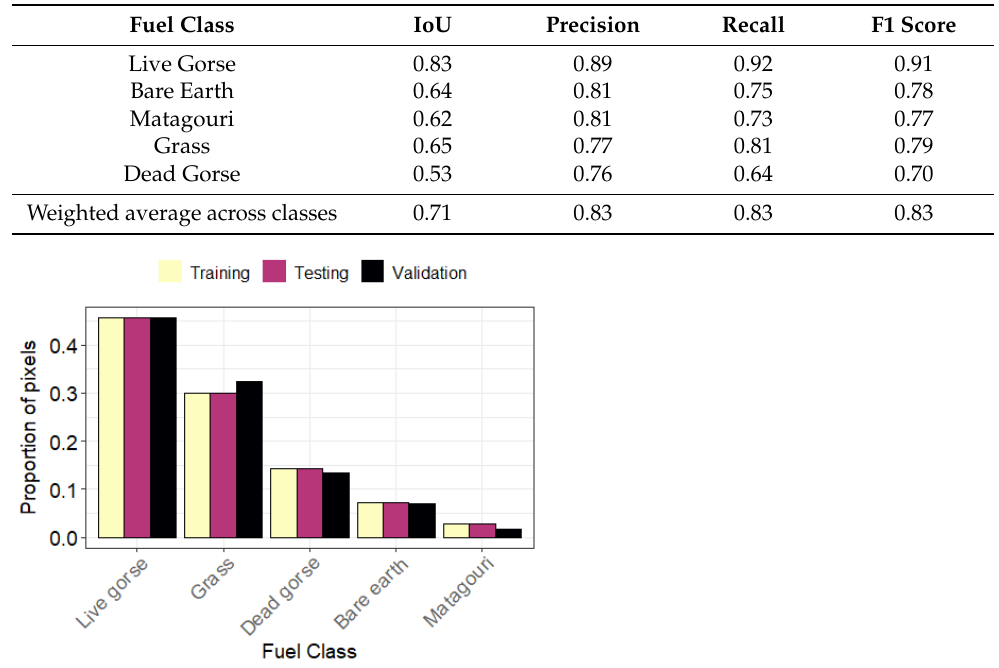
Table 5. Table showing results of semantic segmentation of fuel types as intersection over union (IoU), precision, recall and F1 score, ordered by Precision.